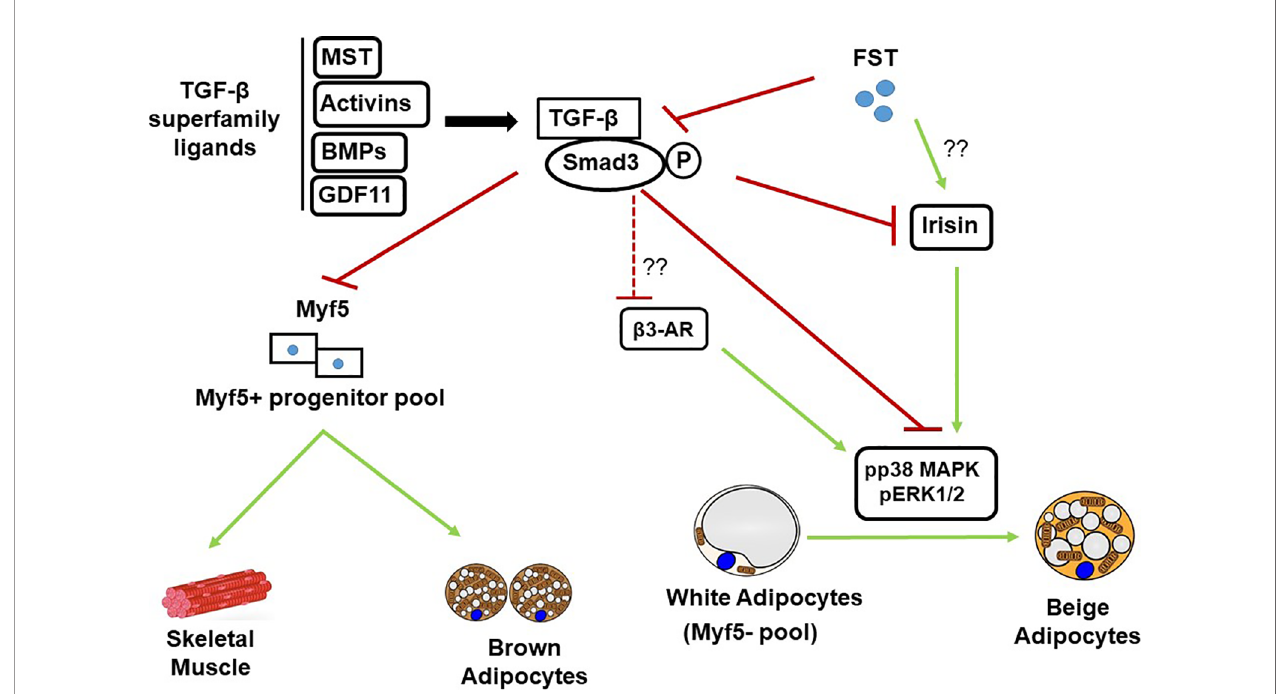
FIGURE 1 | Schematic diagram showing FST modulation of TGF- b /Samd 3 signaling pathway during adipose browning. MST, Myostatin; BMPs, Bone morphogenic proteins; GDF11, Growth and differentiation factor 11; TGF- b , Transforming growth factor